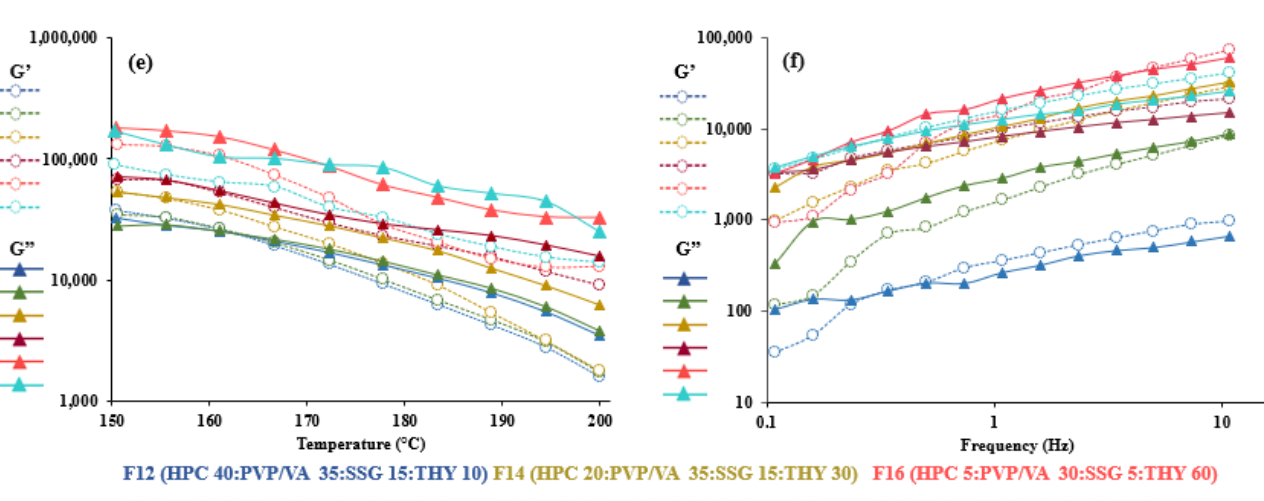
Figure 3. Viscoelastic properties (storage modulus (G’) and loss modulus (G”)) of 67.5–45% HPC: polymer mixtures ( a , b ), 67.5% HPC:disintegrant mixtures ( c , d ) and 40–5% HPC:polymer mixtures ( e , f ) upon increasing temperatures at 1 Hz ( left ) and at 200 °C ( right ) .